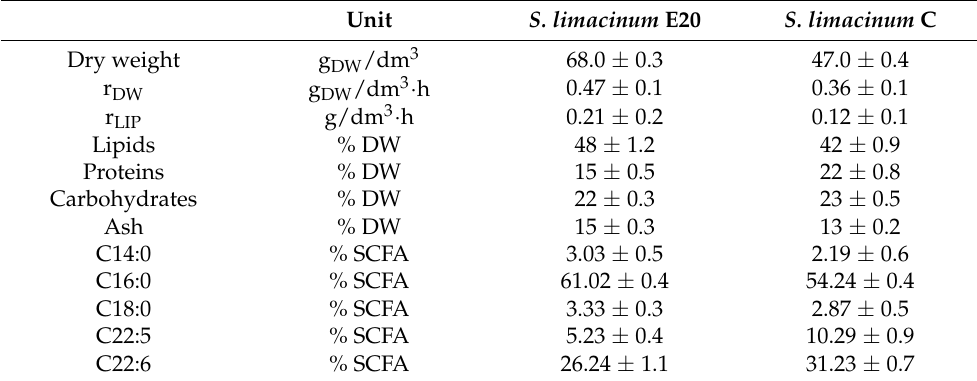
Table 6. Profile of the microalgal